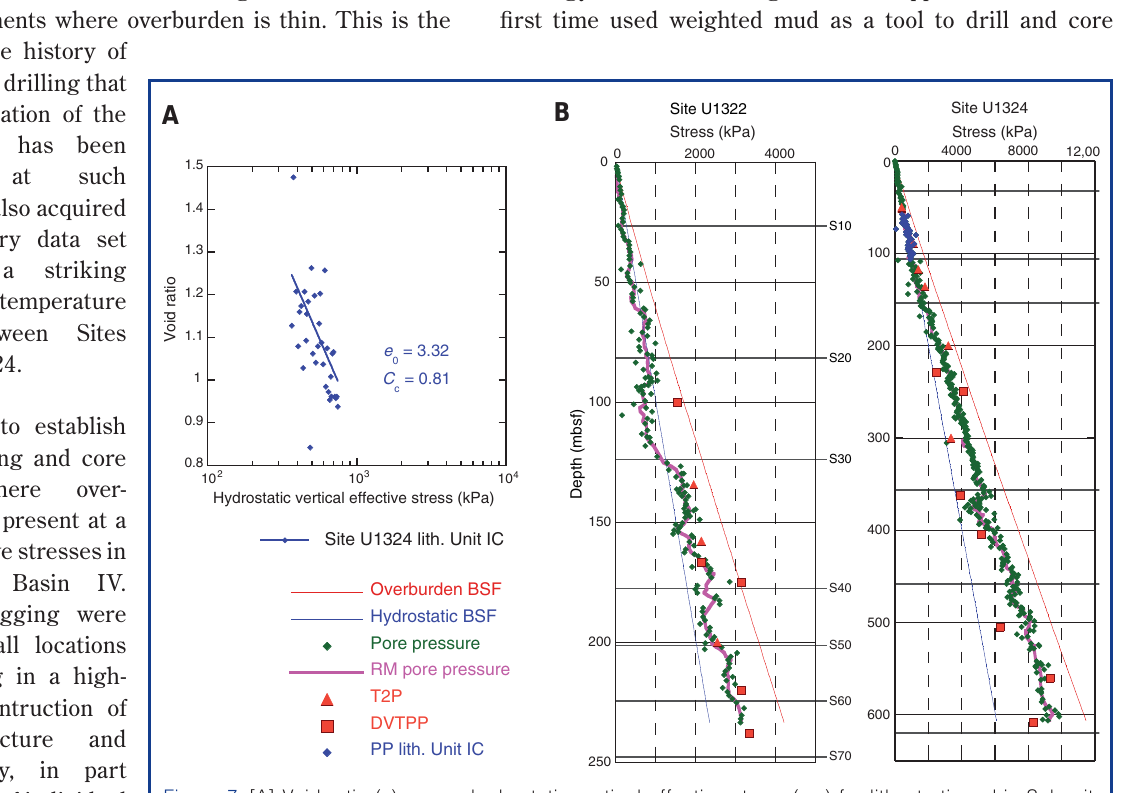
Figure 7. [A] Void ratio (e) versus hydrostatic vertical effective stress ( σ vh ) for lithostratigraphic Subunit IC at Site U1324. Reference void ratio (e 0 ) and compression index (C c ) are derived from fit of type e = e 0 – C c ln( σ vh ). [B] Pore pressures for Site U1322 and U1324 are derived from parameters derived in [A] assuming that lithostratigraphic Subunit IC (blue dots) at Site U1324 is hydrostatically pressured. Pore pressures recorded at end of temperature and dual pressure probe (T2P) (red triangles) and DVTPP (red squares) deployments are also shown. BSF = below seafl oor, RM = running mean, PP = pore